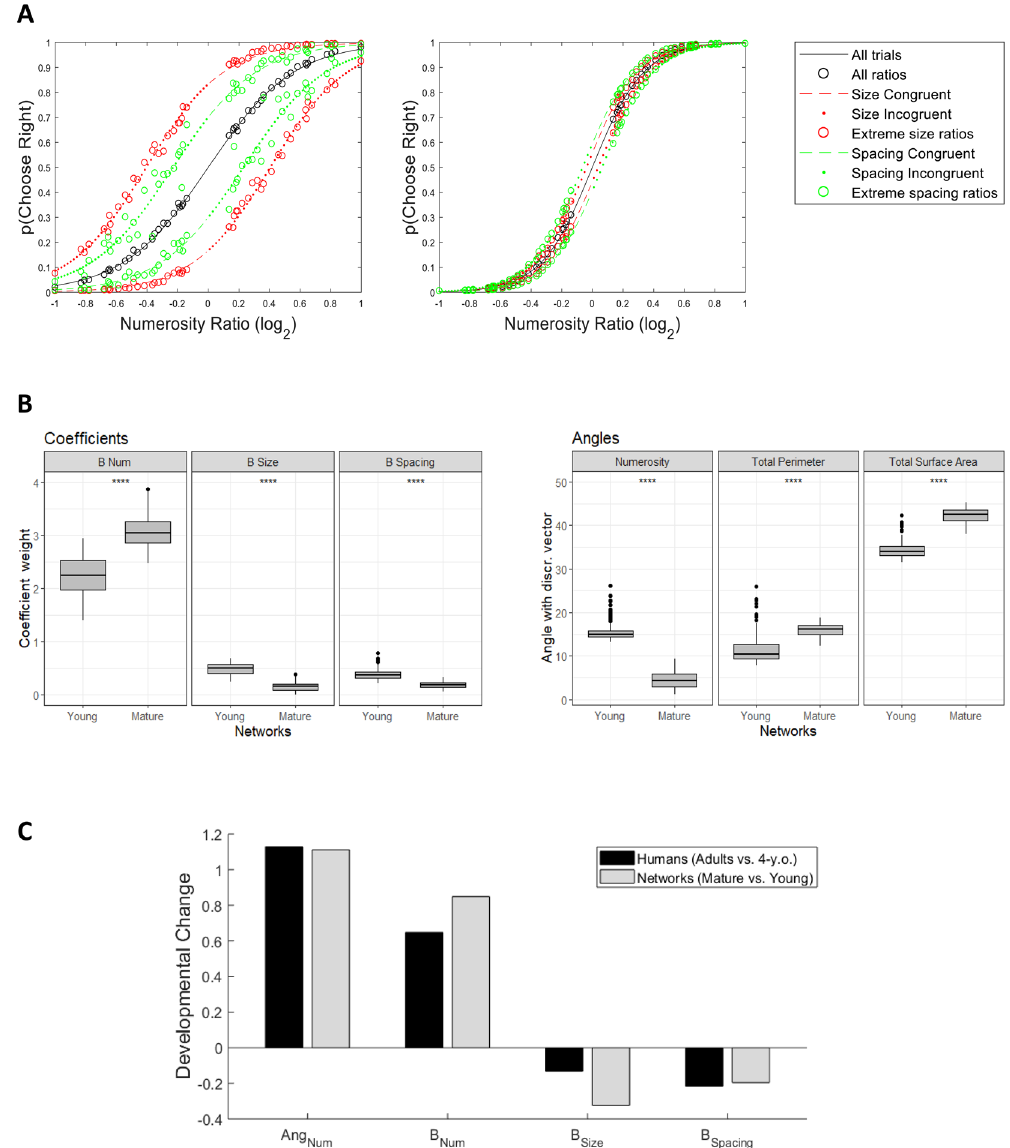
Figure 3. Maturation of number acuity in deep networks. ( A ) GLM fit for one Young (left panel) and one Mature (right panel) network, visualized as in 41 . Black lines indicate the model fit for all data (black circles). Red color shows data and model fits for the trials with extreme Size ratio, while green color shows data and model fit for trials with great Spacing ratio. Dashed lines indicate that Size or Spacing were congruent with numerosity, while dotted lines indicate incongruent trials. ( B ) Left panel: Differences in Numerosity, Size and Spacing coefficients, measured separately for the Young and Mature networks. Right panel: Differences in angles between the discrimination vector and the most relevant non-numerical features, measured separately for the Young and Mature networks. ( C ) Comparison between angle and coefficients changes in humans (data replotted from 24 ) and deep networks. Note that angle differences for both humans and networks have been scaled by a factor of 10 for visualization